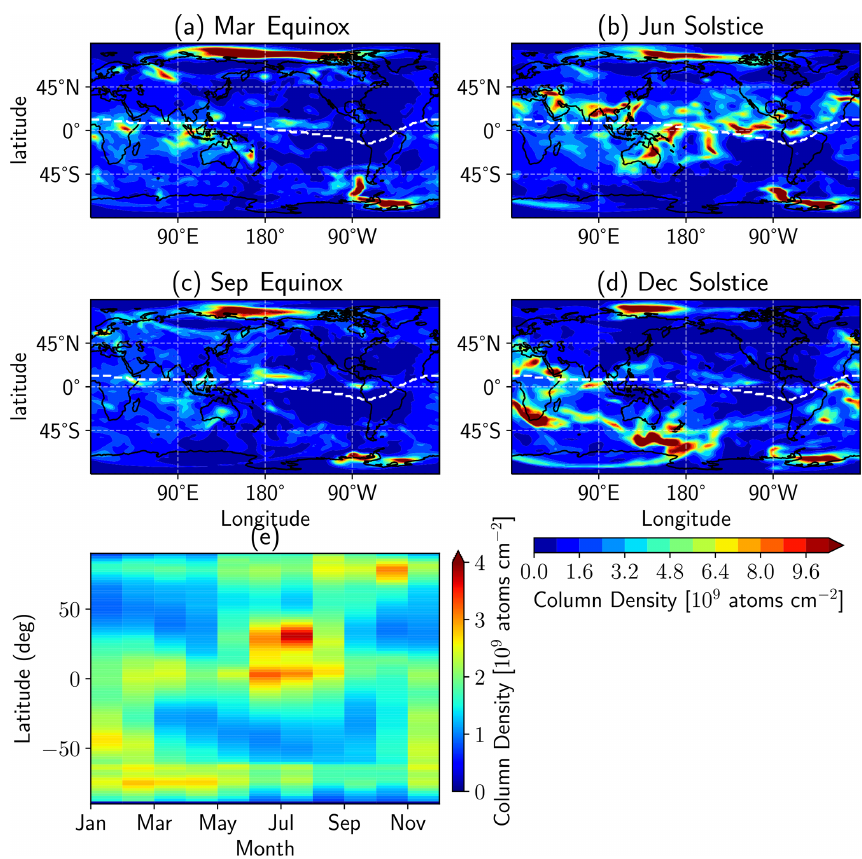
Figure 3. (a–d) Global geographical distribution of the Mg + column density during the equinoxes and solstices, at 00:00UTC. (e) Seasonal variation of the zonal mean Mg + column density as a function of month and latitude. The dashed white lines indicates the position of the dip